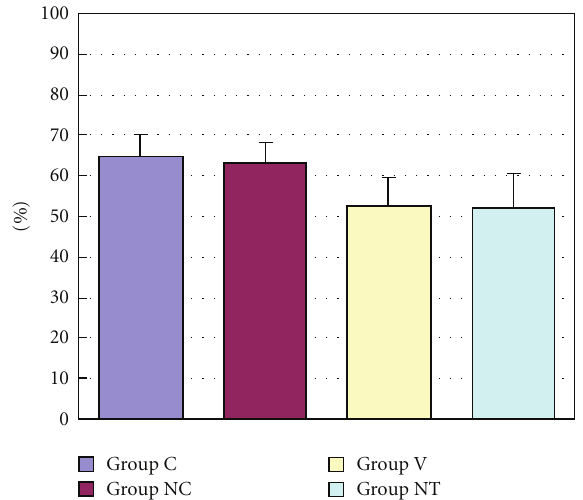
Figure 2: The figure shows R/L value (%), which means the area at risk expressed as percentage of left ventricle. Data are expressed as mean ± S.D. Area at risk revealed no significant di ff erence among all groups, suggesting that the changes in the infarct size observed among the groups did not depend on R/L. Group C: a control group. Group NC: a nicardipine group. Group V: a verapamil group. Group NT: a nitroglycerin group.